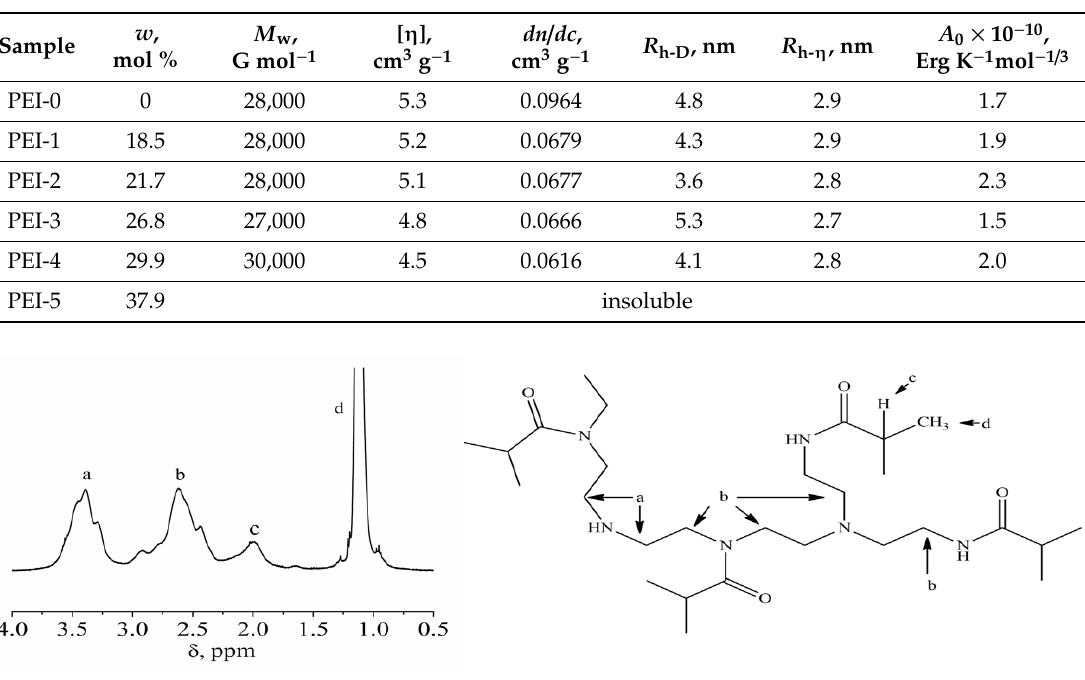
Figure 2. 1 H NMR spectrum and signal assignment for